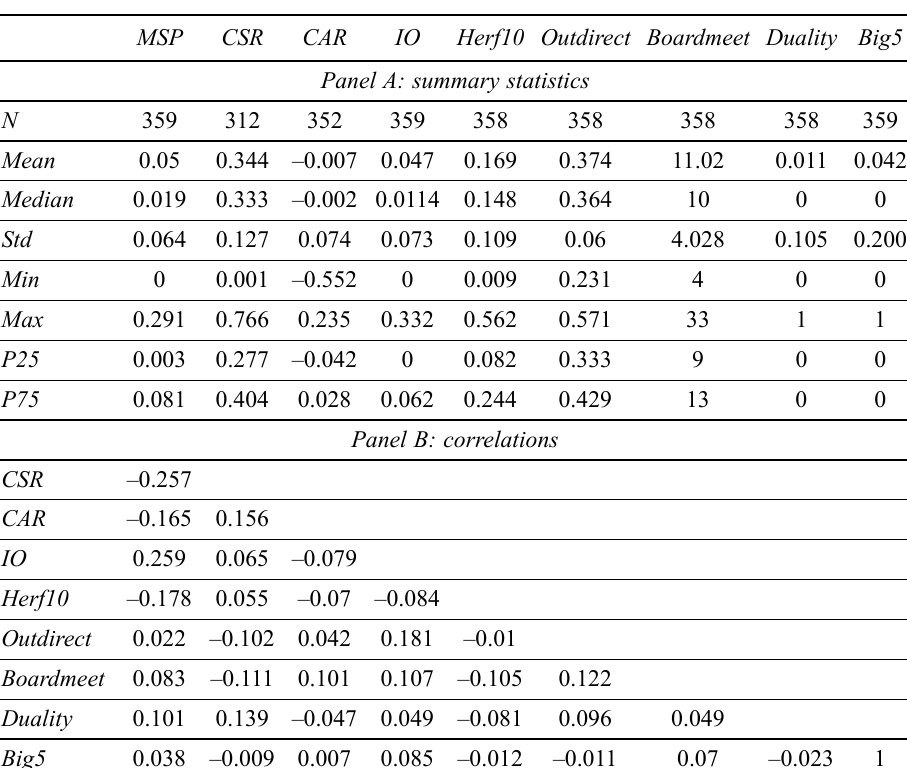
Table 2. Summary statistics and